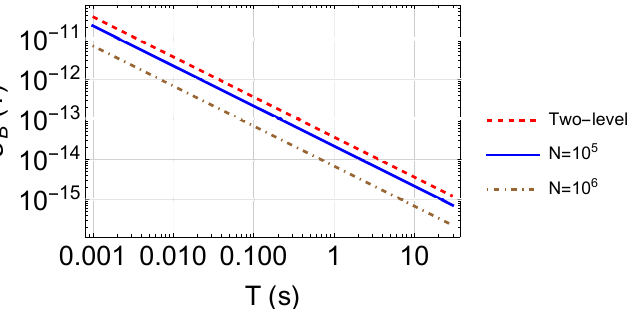
Figure 7. One-shot resolution to magnetic field measurement. The pulse area is π /2, and Equation (6) is chosen as the detection port. The red dashed line as the comparison basis is the resolution employing a microwave in a two-level